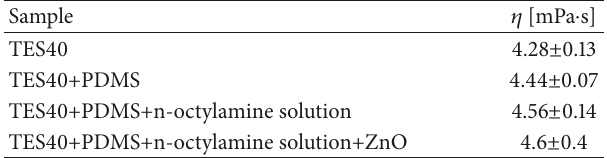
Table 1: Viscosities measured at T=25 ∘ C by rotational rheology of the main component of the sample, TES40, and after adding the dif- ferent components, TES40+PDMS, TES40+PDMS+n-octylamine solution and TES40+PDMS+n-octylamine solution+ZnO